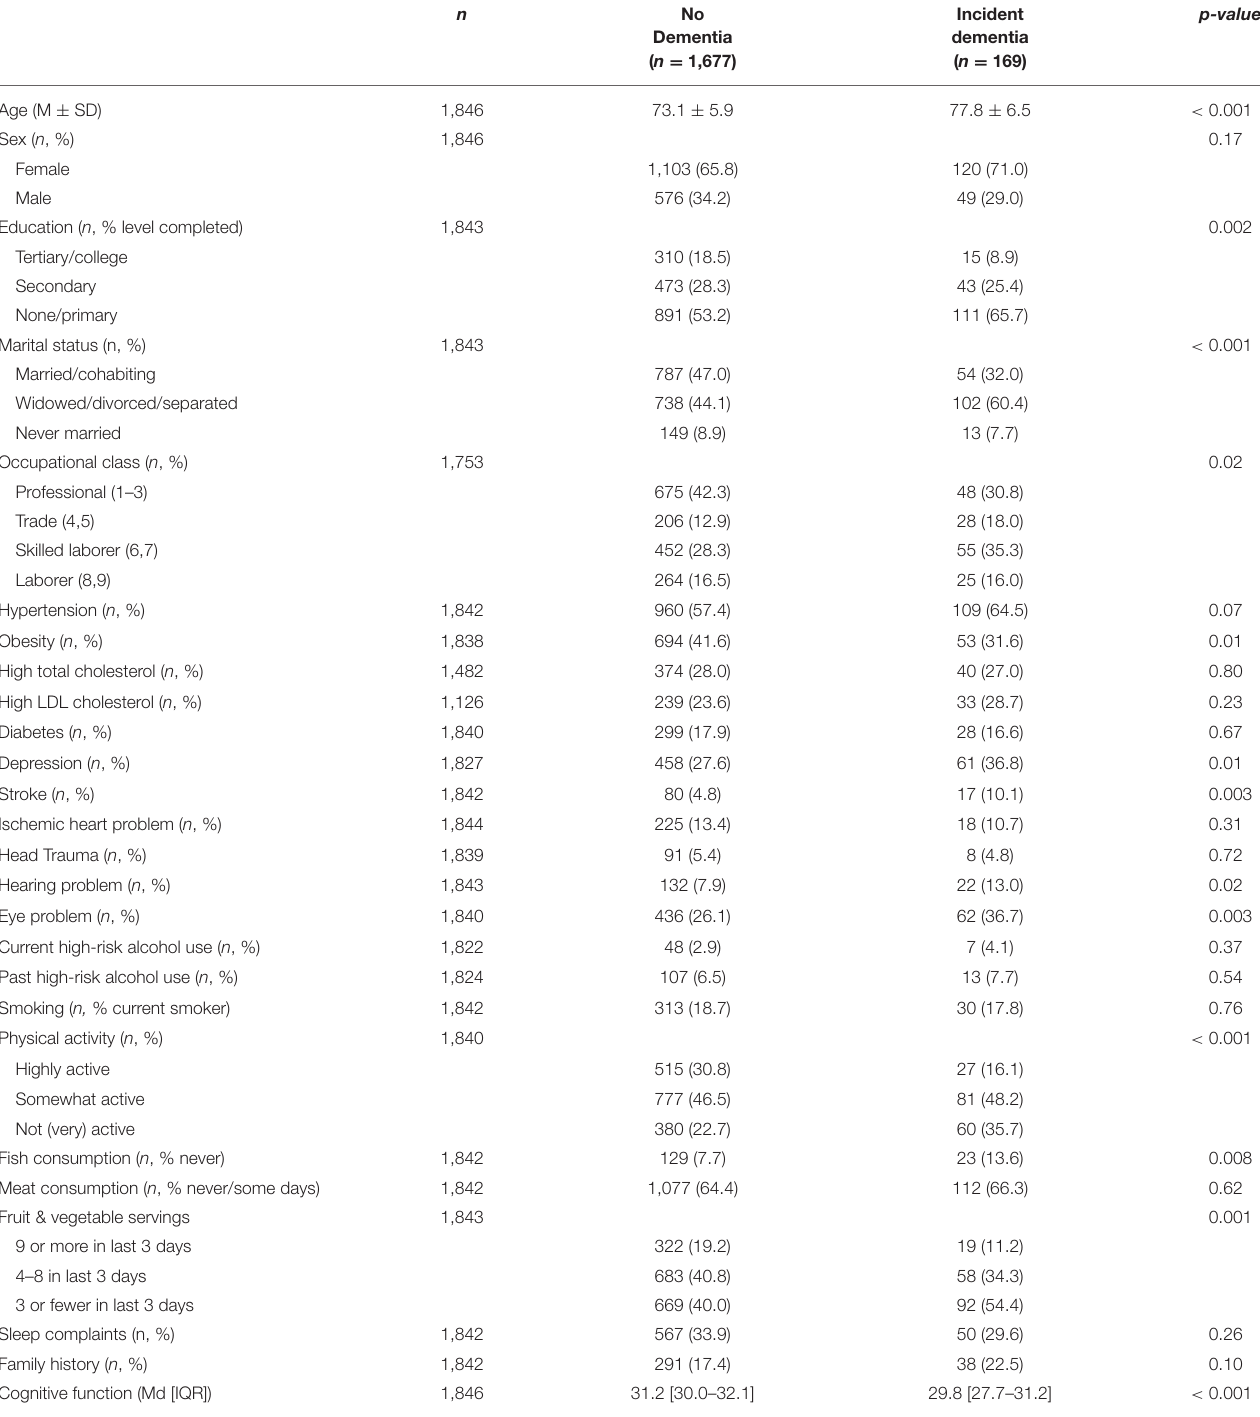
TABLE 1 | Baseline characteristics of participants with and without incident dementia in the Cuban cohort of the 10/66 study ( n = 1,846).